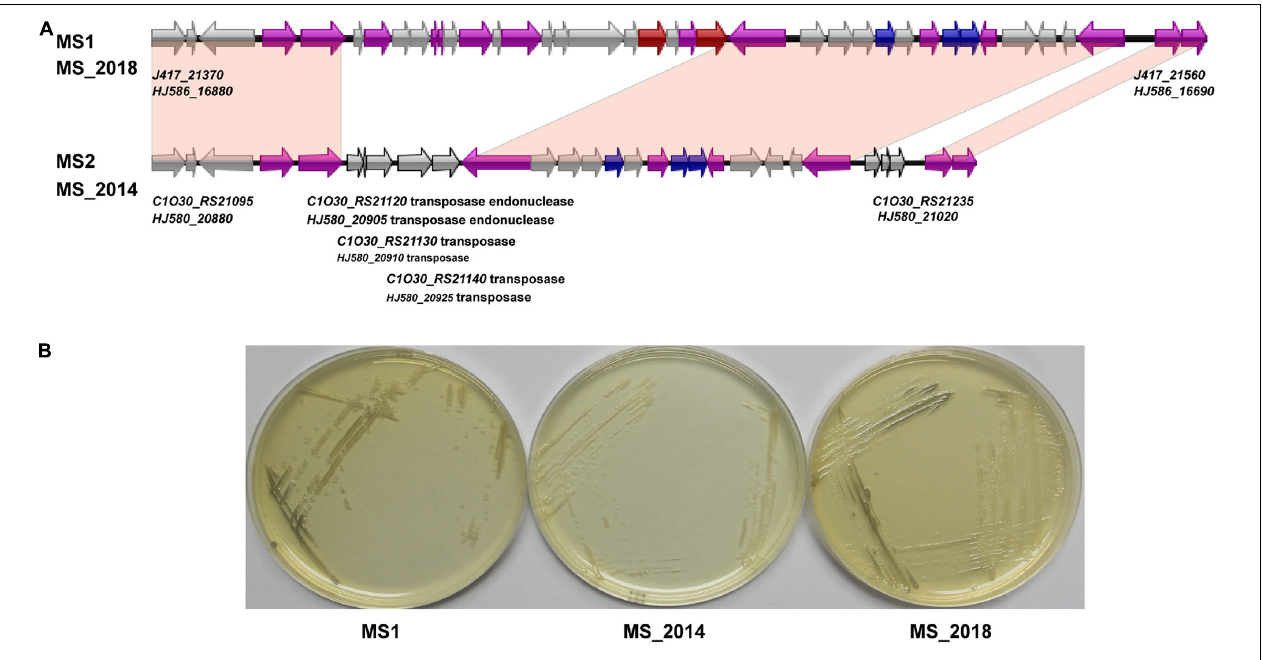
FIGURE 5 | Comparison of the aryl polyene pigment biosynthetic gene cluster and related phenotypes among D . zeae strains isolated from banana. (A) Genomic organization of aryl polyene pigment biosynthetic gene clusters (genes aligned with a shadow are homologous): core biosynthetic genes,